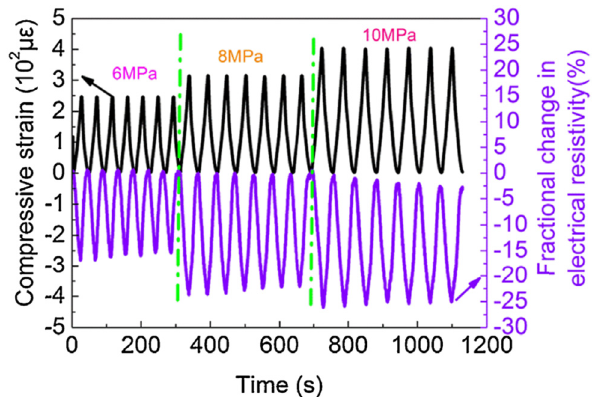
Figure 5: Change of resistivity of CNTCS with di ff erent load ampli - tude [ 49 ] .